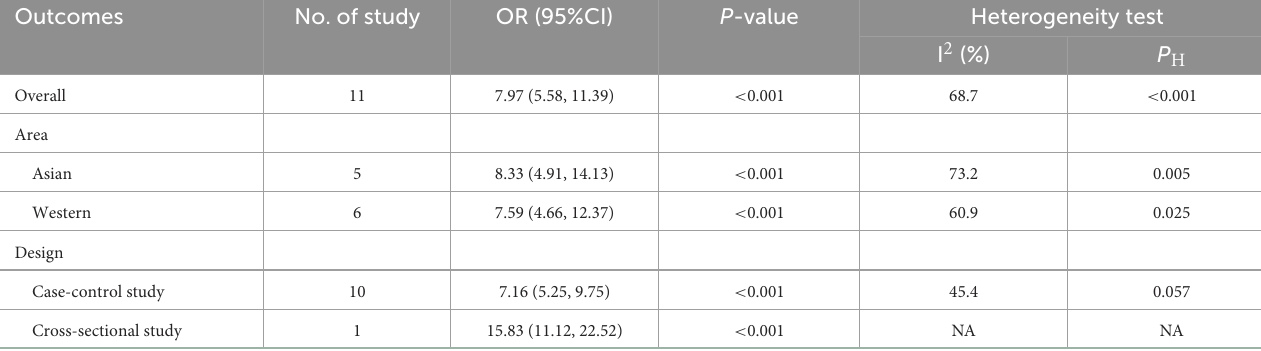
TABLE 3 Subgroup analyses of hypoplastic/aplastic A1 and anterior communicating artery (AcomA) aneurysm